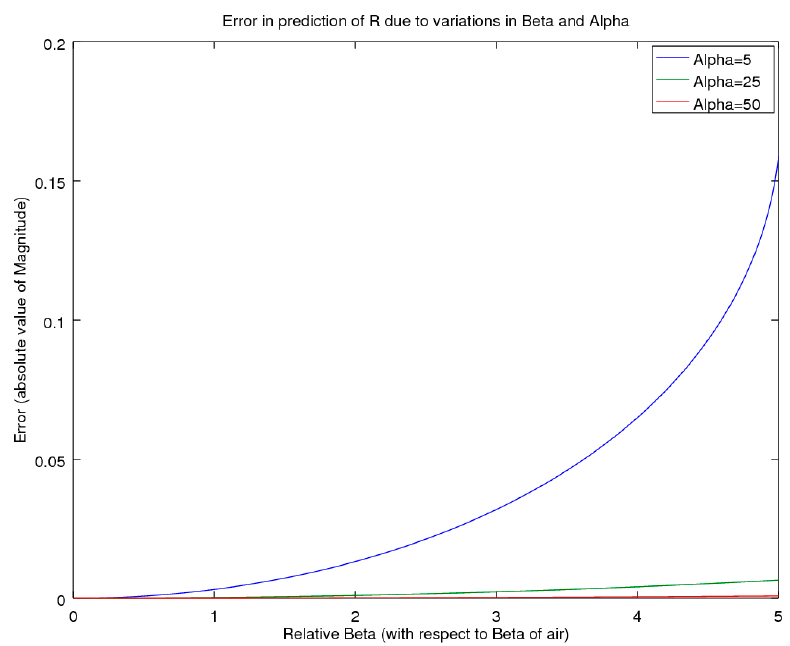
Figure 9. Error comparison for the CSMM simplified new method utilizing only pressure-magnitude readings |H 30 |. Error is reported as magnitude of the absolute value of the reflection coefficient R.